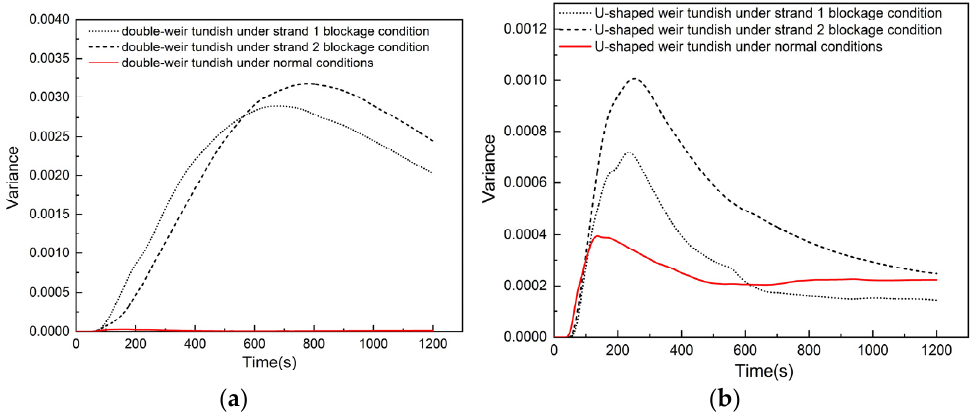
Figure 12. Variance of outflow percentage of four-strand tundish under single-strand blockage and